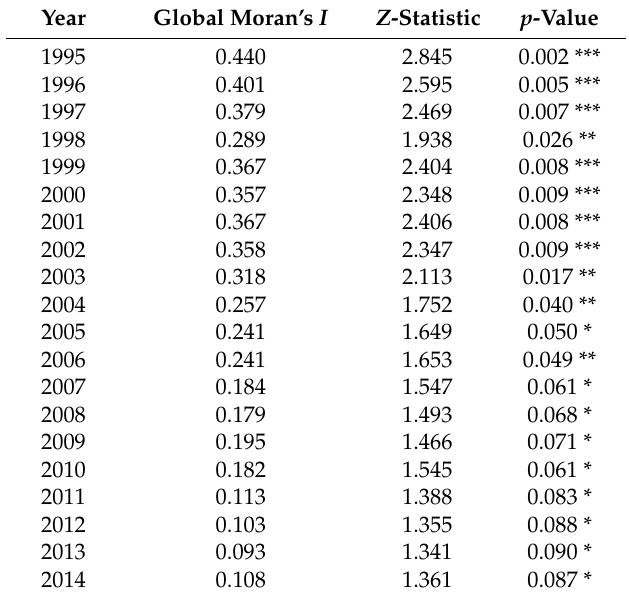
Table 2. Global Moran’s I of the carbon intensity in 29 B&R countries during